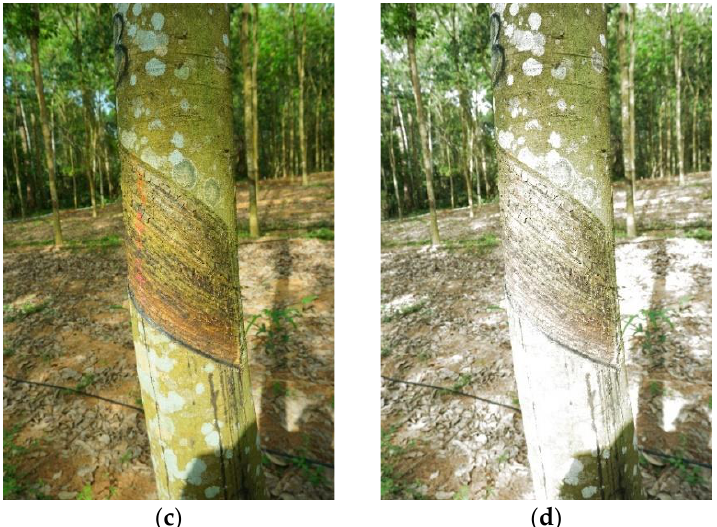
Figure 2. Image Enhancement. ( a ) Random translation, ( b ) Adding noise, ( c ) Adjusting saturation, ( d ) Adjusting brightness.